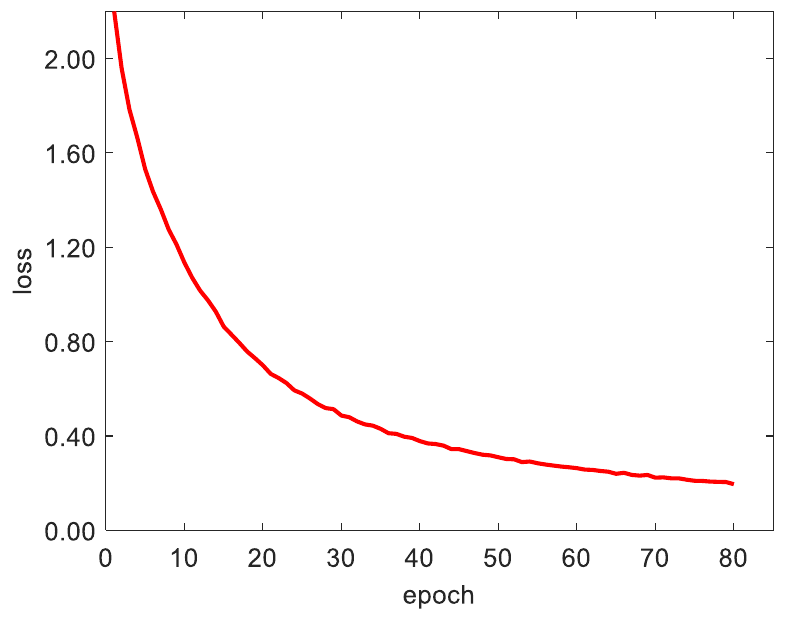
Figure 13. Loss function curve.